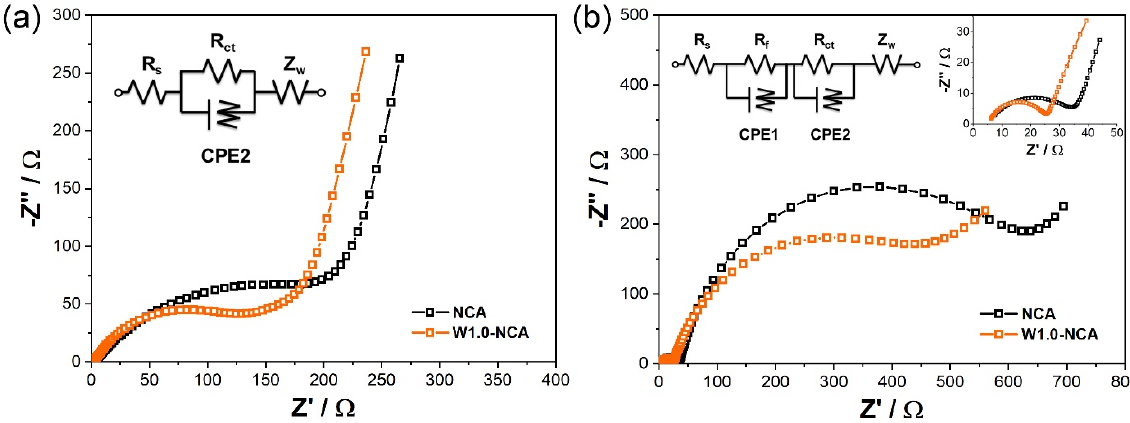
Figure 6. CV of ( a ) NCA, ( b ) W1.0 - NCA.